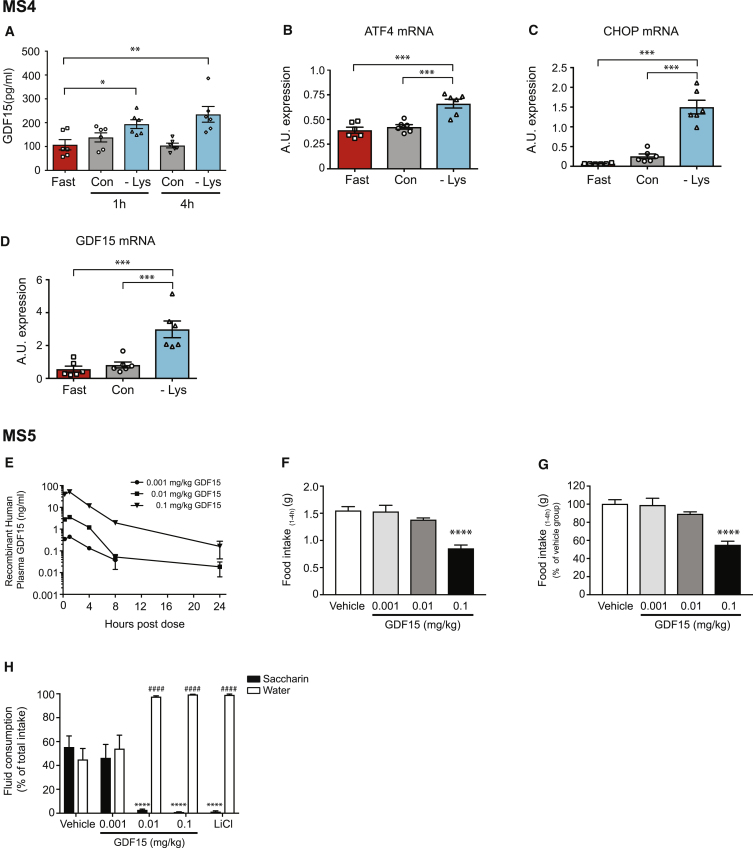
GDF15 Is Upregulated in Response to a Lysine-Deficient Diet and Induces Conditioned Taste Aversion in Mice(A–D) Mouse Study 4 (MS4): (A) GDF15 serum concentrations and (B) ATF4, (C) CHOP, and (D) GDF15 mRNA expression in livers of 11- to 12-week-old female mice that were fasted overnight and then fed a control chow (Con) or lysine-deficient diet (−Lys) for 4 h. A blood sample was withdrawn at 1 h following the beginning of the meal. Serum and mRNA (4 h time point only) data are expressed as mean ± SEM (n = 6 mice per group) with mRNA normalized to B2M gene expression. ∗p < 0.05, ∗∗p < 0.01, ∗∗∗p < 0.001 by one-way ANOVA.(E) Mouse Study 5 (MS5): Circulating plasma GDF15 concentrations after a single dose of recombinant GDF15 in mice; dose response (n = 3/ group).(F and G) Cumulative food intake measured between 1 and 4 h post-GDF15 dose expressed as total grams (F) or percent (%) of vehicle control (G) (n = 7–8/group). Data are presented as mean ± SEM. ∗∗∗∗p < 0.0001 versus vehicle by one-way ANOVA with Bonferroni multiple comparison post-test.(H) Saccharin and water consumption during conditioned taste aversion test during GDF15 treatment (n = 8–16/group). Data are presented as mean ± SEM and analyzed using a two-way ANOVA with Bonferroni multiple comparison post-test to compare proportion of saccharin water and water consumption between groups of GDF15 or LiCl treatment to vehicle. ∗∗∗∗(saccharin) or ####(water) p < 0.0001. See also Figure S4.